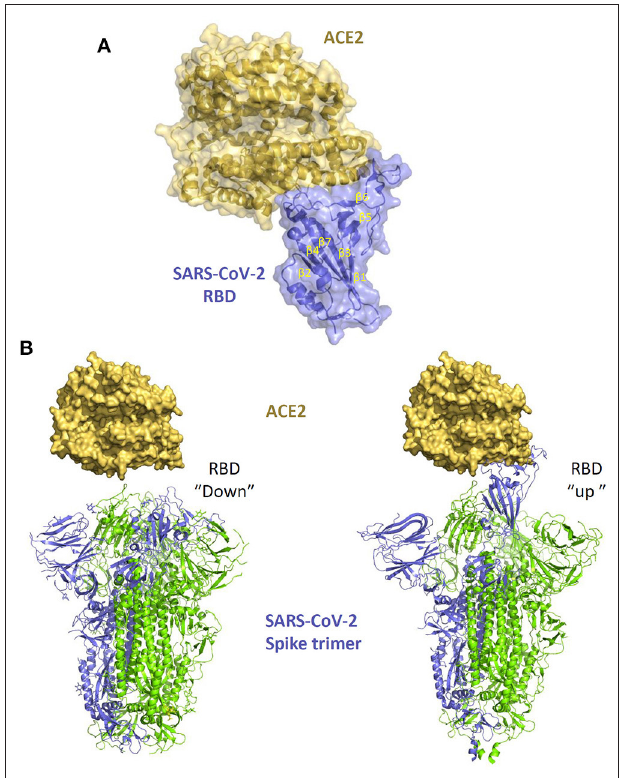
FIGURE 5 | The interaction of SARS-CoV-2 spike with ACE2. (A) structure of SARS-CoV-2 spike RBD in complex with ACE2 (PDB 6M0J). (B) different conformations of the spike trimer with RBD “down” (PDB 6ZB5) and RBD “up” (PDB 6zGG) which shows the exposure of the RBM within the RBB which facilitates the interaction with